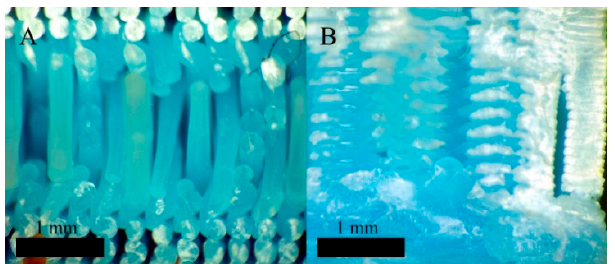
Figure 15. ( A ) Test specimen with a layer height of 0.3 mm and filament width of 0.3 mm. Test specimen 9_2. Microscopic photography. ( B ) Test specimen with a layer height of 0.1 mm and filament width of 0.6 mm. Test specimen 21_3. Microscopic photography.